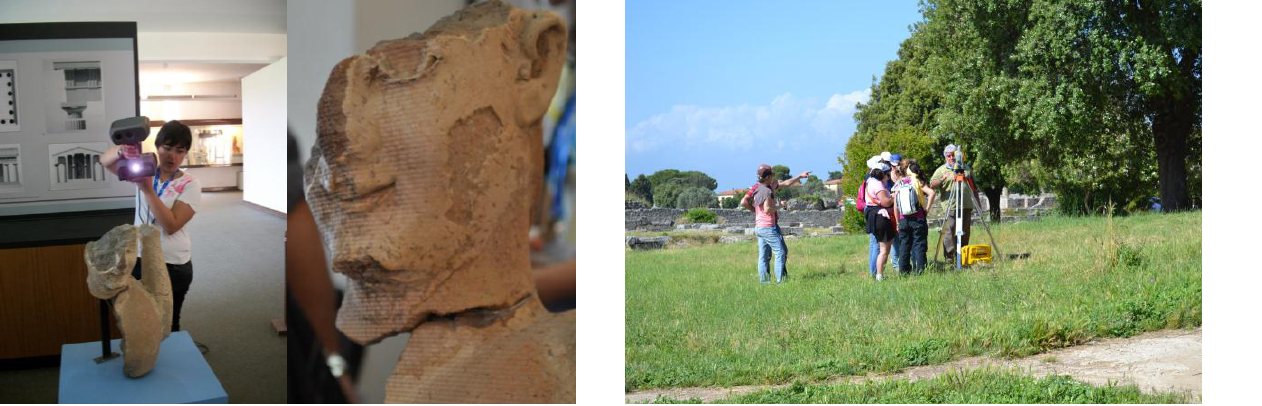
Figure 3. Data acquisition of the Sphinx with Artec MH/MHT